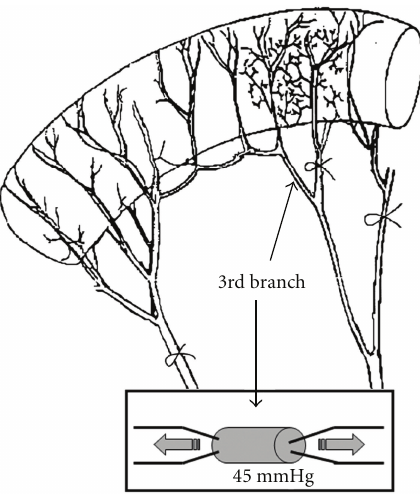
Figure 1: The third branch of mesenteric vessels to be dissected and mounted in a pressurized myograph in rat studies. The vessel is attached to micropipettes, connected to transducers keeping 45mmHg as a fixed intraluminal pressure for functional